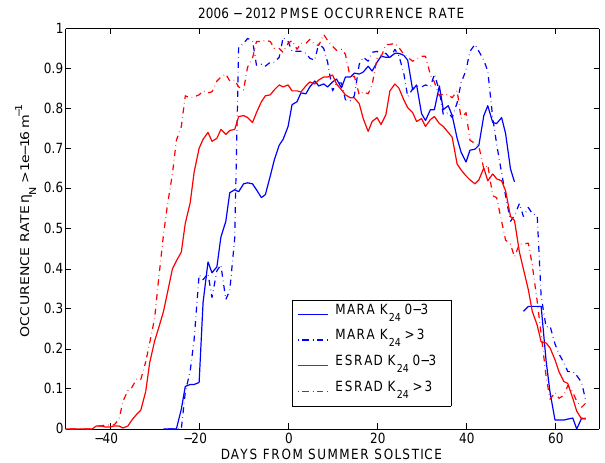
Fig. 8. Seven-day running mean occurrence rates of PMSE as a function of magnetic disturbance level. PMSE is defined as occur- ring if the one-hour average η N > 10 − 16 m − 1 at any